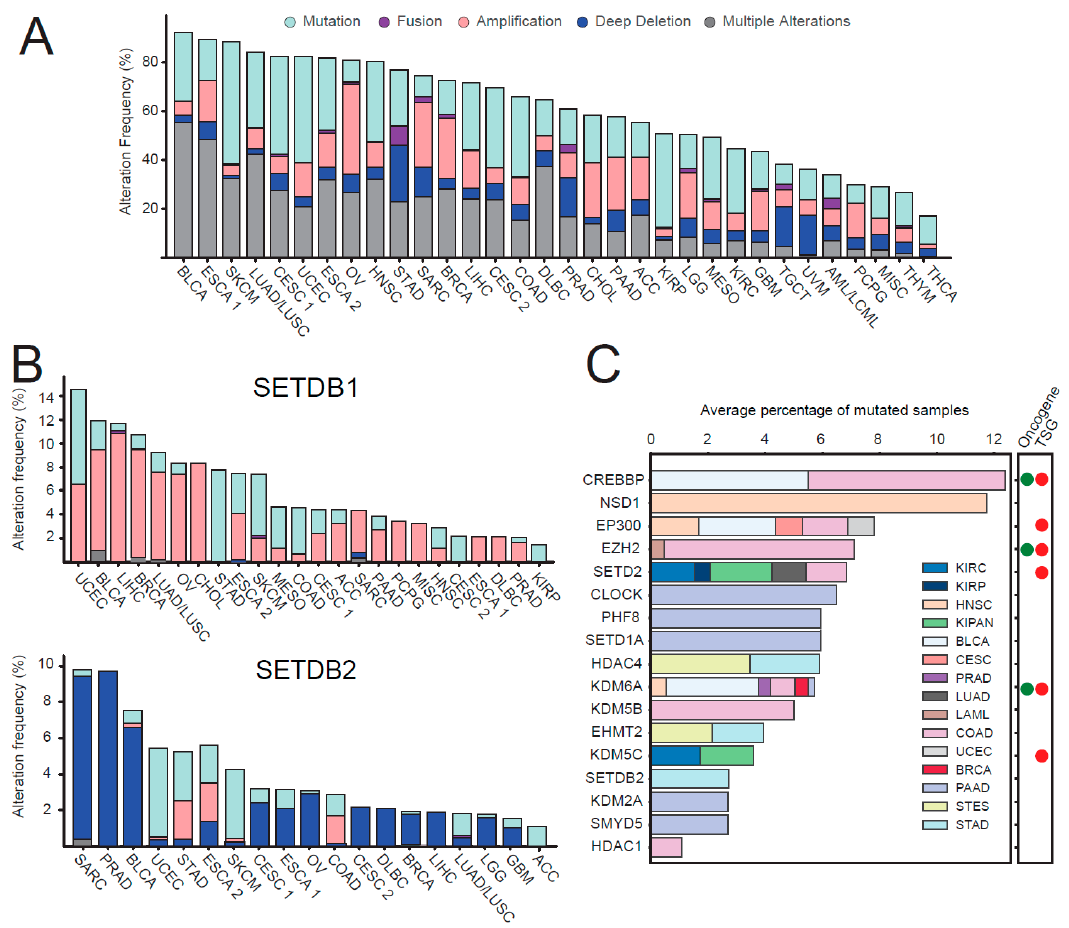
Figure 5. Mutational analysis of HMEs in cancer. ( A ) Stacked bar plot summarizing the frequency (minimum % of altered cases = 1) and type of mutations of HMEs in the TCGA PanCan 2018 cohort [47]. Different colors correspond to different types of mutations. ( B ) Same representation as in A for the SETDB1 and SETDB2 genes. ( C ) Horizontal stacked bar plot for significantly mutated HME genes (MutSig2CV adjusted p -value < 0.01). The bar widths are proportional to the number of samples mutated divided by the cohort size. When a gene is significantly mutated in multiple cancer types, the resulting cohort is given by the sum of the total samples of the individual cohorts. The right panel indicates whether the genes have been reported as oncogenes and/or tumor suppressor genes (TSG) in at least one tumor type in the Cancer Census Genes [48]. AML: Acute Myeloid Leukemia; ACC: Adrenocortical carcinoma; BLCA: Bladder Urothelial Carcinoma; LGG: Brain Lower Grade Glioma; BRCA: Breast invasive carcinoma; CESC: Cervical squamous cell carcinoma (1) and endocervical adenocarcinoma (2); CHOL: Cholangiocarcinoma; CML: Chronic Myelogenous Leukemia; COAD: Colon adenocarcinoma; ESCA: Esophageal squamous cell carcinoma (1) and esophagogastric adenocarcinoma (2); GBM: Glioblastoma multiforme; HNSC: Head and Neck squamous cell carcinoma; KIRC: Kidney renal clear cell carcinoma; KIRP: Kidney renal papillary cell carcinoma; LIHC: Liver hepatocellular carcinoma; LUAD; Lung adenocarcinoma; LUSC: Lung squamous cell carcinoma; DLBC: Lymphoid Neoplasm Diffuse Large B-cell Lymphoma; MESO: Mesothelioma; MISC: Miscellaneous; OV: Ovarian serous cystadenocarcinoma; PAAD: Pancreatic adenocarcinoma; PCPG: Pheochromocytoma and Paraganglioma; PRAD: Prostate adenocarcinoma; SARC: Sarcoma; SKCM: Skin Cutaneous Melanoma; STAD: Stomach adenocarcinoma; TGCT: Testicular Germ Cell Tumors; THYM: Thymoma; THCA: Thyroid carcinoma; UCS: Uterine Carcinosarcoma; UCEC; Uterine Corpus Endometrial Carcinoma; UVM: Uveal Melanoma.